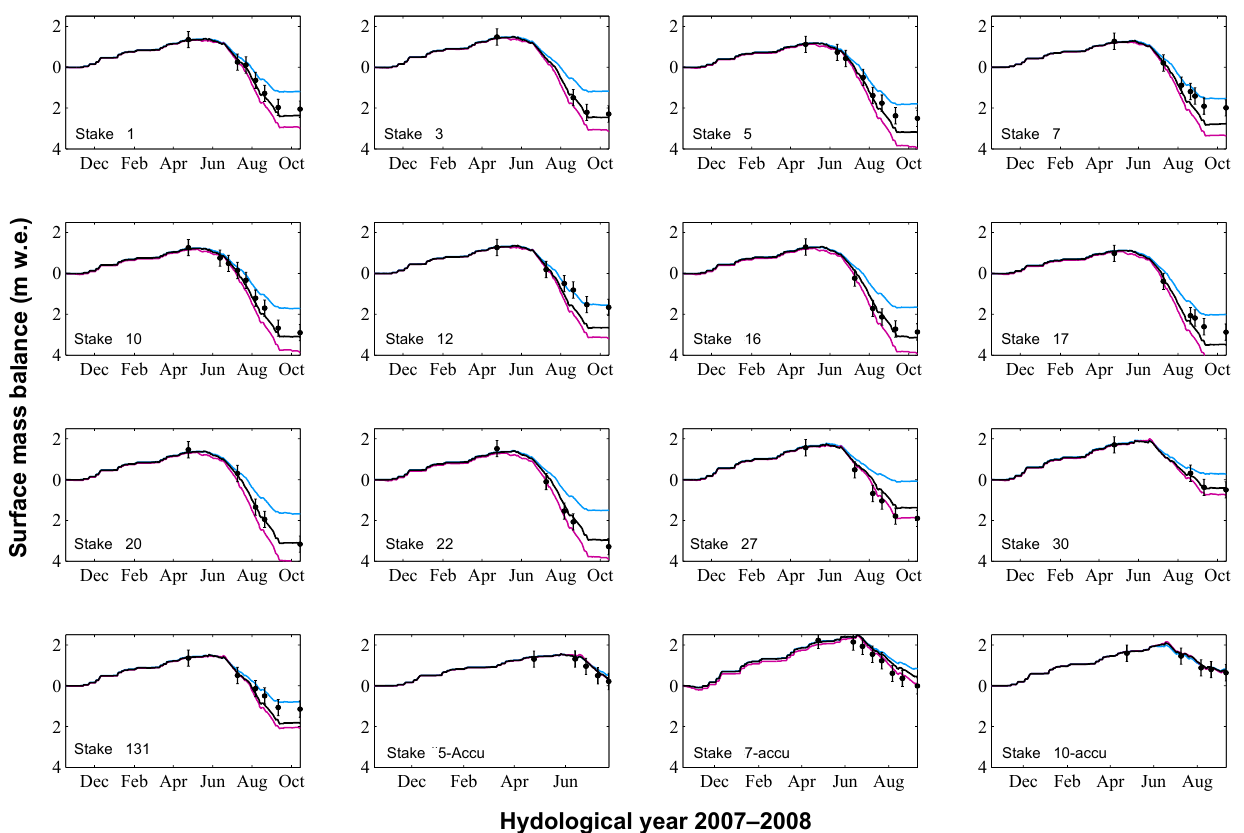
Figure 7. Surface mass balance (in mw . e . ) at some selected measurement points in the accumulation (accu) and ablation areas of Saint- Sorlin Glacier (numbers refer to the stake numbers shown in Fig. 1) over the hydrological year 2007–2008 (from 17 October to 10 October). Black curves represent the simulated mass balance with corrected forcing (Sect. 2.3.4). Pink curves are the simulations without the incoming longwave radiation correction. Blue curves are the simulations without the wind speed correction. Black dots represent the measurements and their